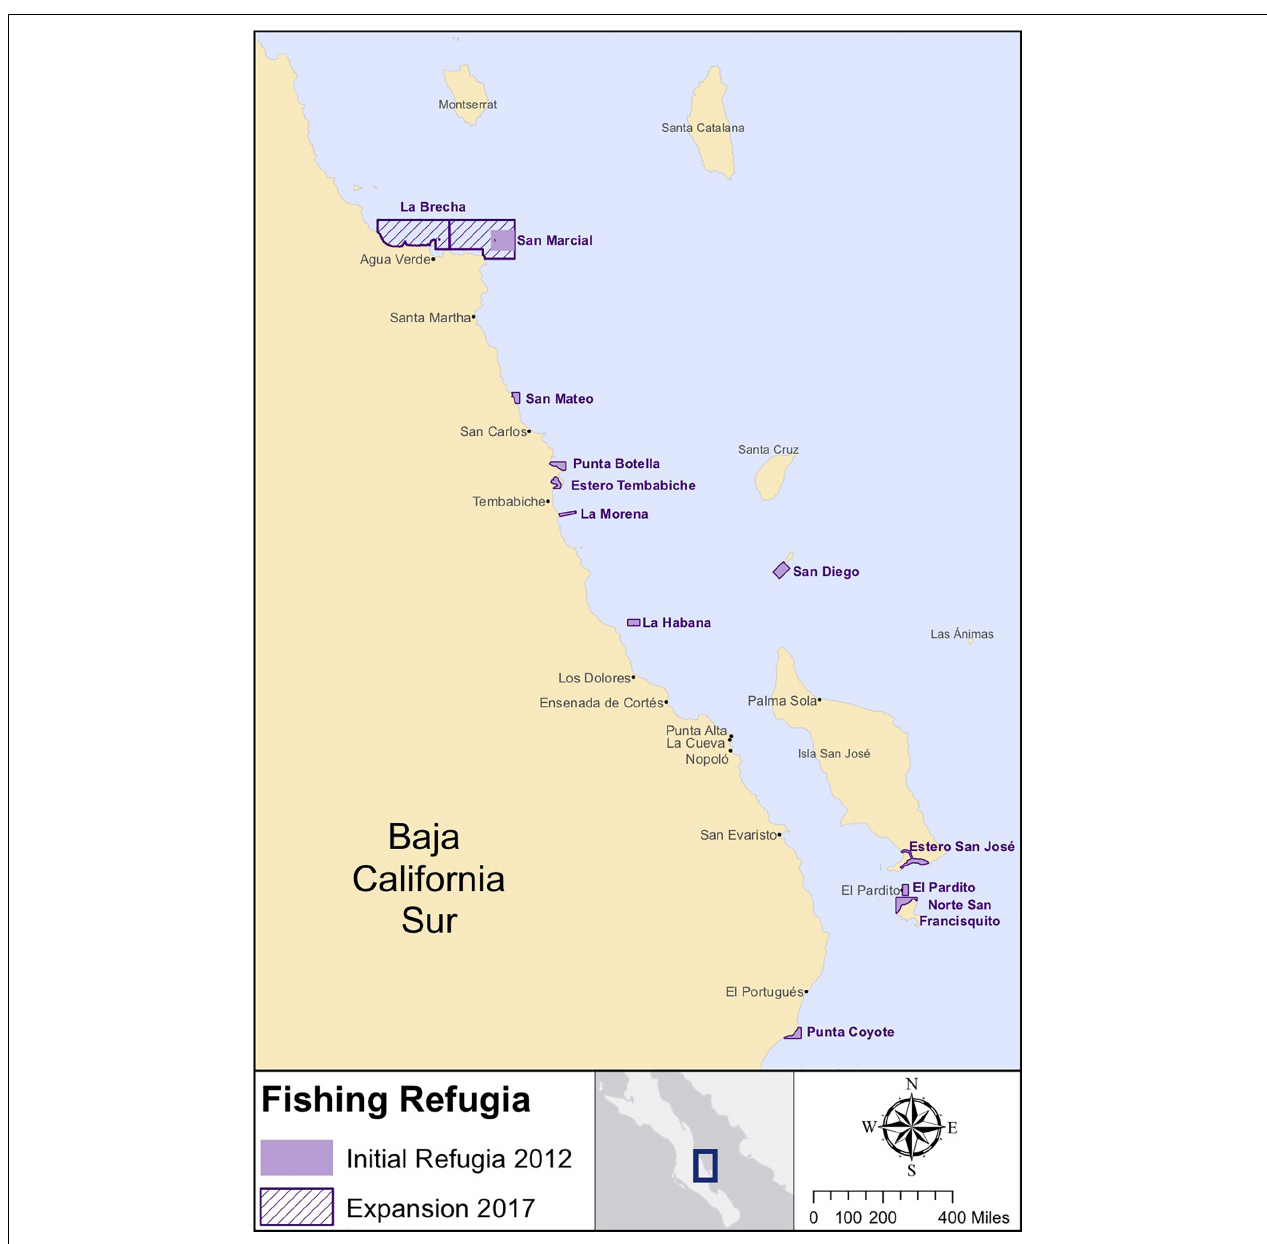
FIGURE 2 | Divergent pattern of fishing refugia adaptation after first 5 years. Original map is shown in light purple (established 2012 for 5 years). Note largest area in the north, San Marcial, created by fishers in the town of Agua Verde. In 2017, all fishing refugia were renewed for another 5 years with no changes, except San Marcial, which was expanded (shown in dark purple hatching). Map designed and created by Erin Ristig based on legal maps (DOF, 2012,